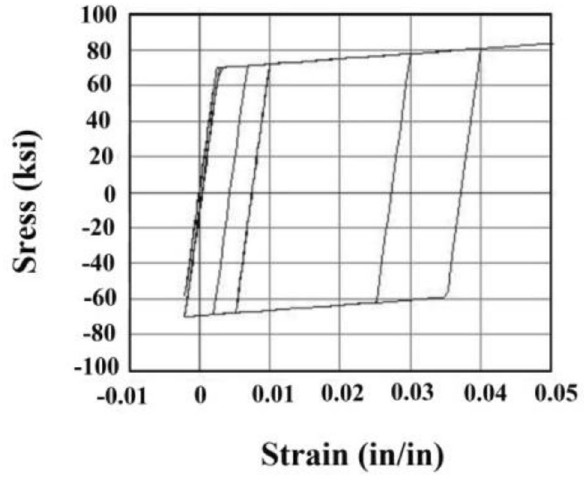
Fig. 8 The model of the cyclic response of Steel 01 without iso- tropic hardening